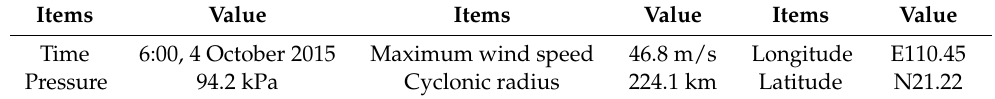
Table 2. The measured data of Typhoon Mujigae.